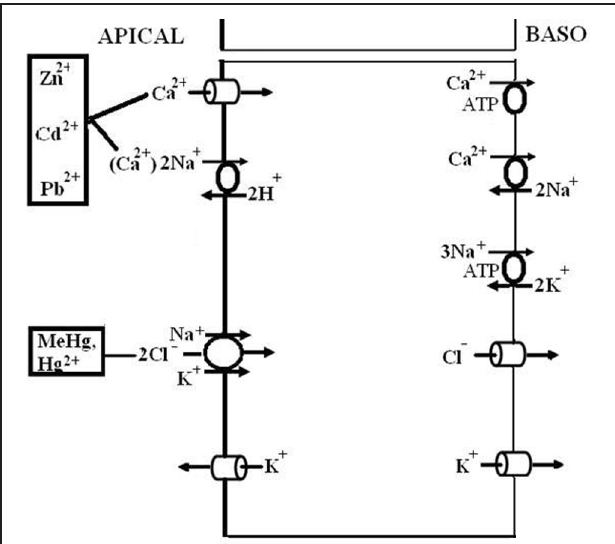
FIGURE 10 | Model of hypothetical transcellular uptake of the toxic divalent metals ions Zn 2 + , Cd 2 + , Pb 2 + , and MeHg across the gill epithelium of the weak and medium hypersomoregulating Crustacea is presented. There are many evidences about apically located interactions of the divalent toxic metals with Ca 2 + channel. An electroneutral Na + /H + exchanger and Ca 2 + /2H + as proposed by lobster hepatopancrease brush border membrane vesicles might be present. Non-specific inhibition of Na/K/2Cl cotransport by CH 3 HgCl and HgCl 2 was reported. Basolaterally located Ca 2 + -ATPase and Ca 2 + /2Na + exchange are candidates for basolateral exit of the trace metals. Numerous studies has shown inhibition of Na + ,K + -ATPase by Cd 2 + , Pb 2 + , Zn 2 + , and consequently, secondary active transport mechanisms generated by this